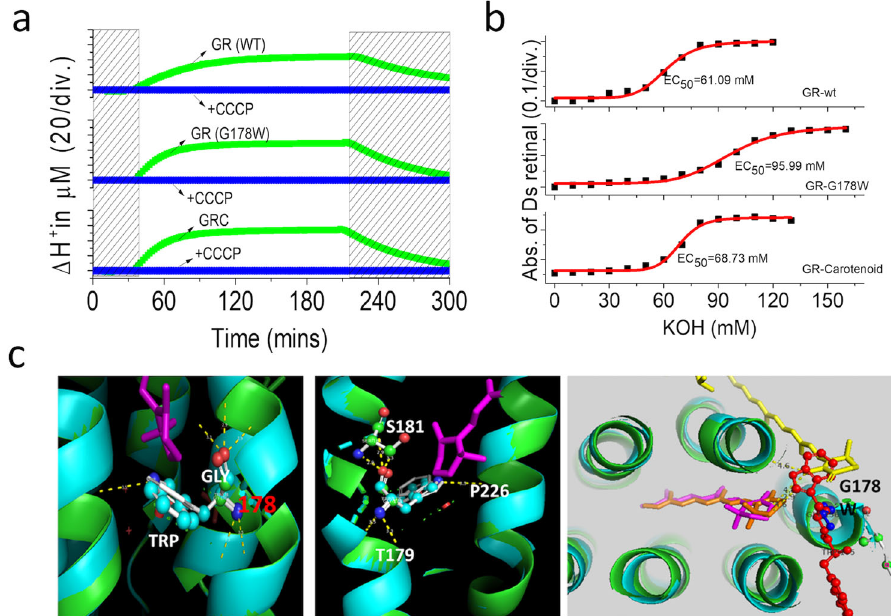
Fig. 3 A single mutation G178W replaces and mimics the carotenoid binding. a Comparison of proton pumping of GR wild-type, G187W mutant, and GR- carotenoid. b Retinal bleaching from opsin when exposed to high pH condition, G178W showed pH tolerance over GR-bound carotenoid and wilt-type. c Local view of G178W mutant and the polar interactive change of surrounding residues, while replacement of Gly to Trp make the overlap ring to the carotenoid 4-keto ring of